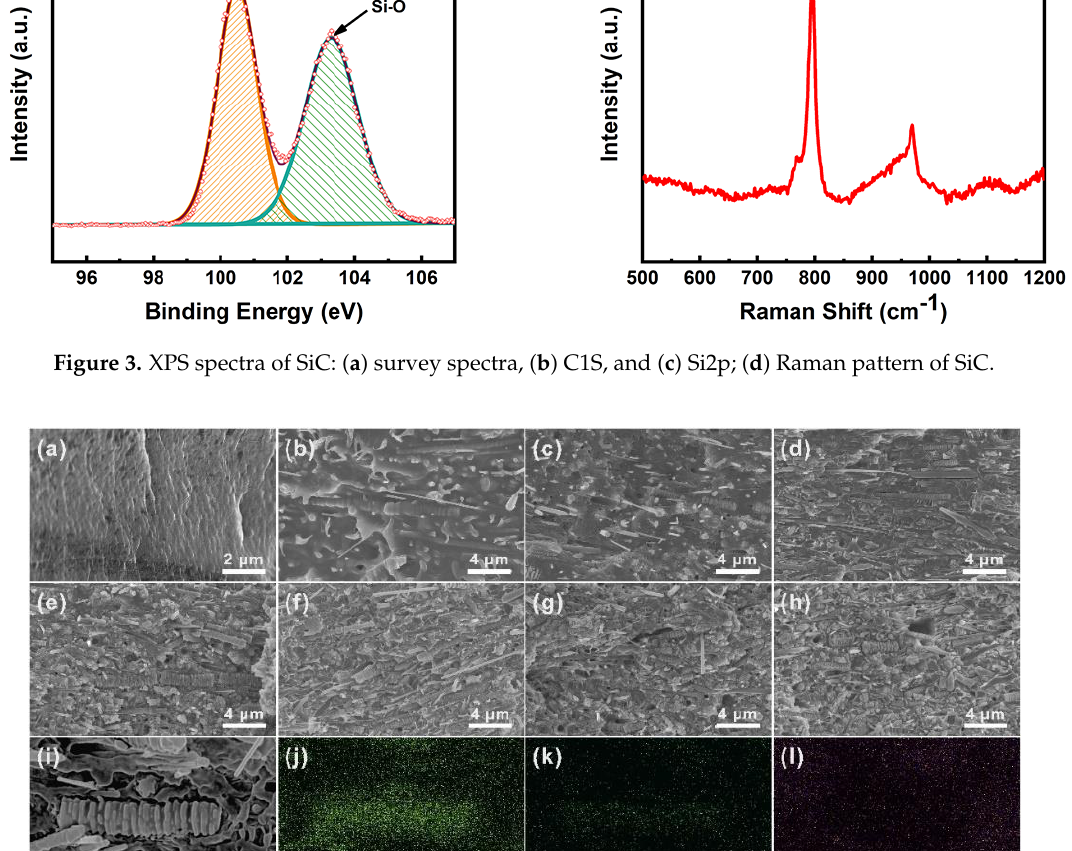
Figure 4. ( a ) SEM image of cross section of pure PVDF. Sectional SEM images of SiC/PVDF with ( b ) 10 wt%, ( c ) 20 wt%, ( d ) 30 wt%, ( e ) 40 wt%, ( f ) 50 wt%, ( g ) 60 wt%, and ( h ) 70 wt% filler content. ( i ) Enlarged SEM image of the 70 wt% SiC/PVDF and corresponding EDS mappings of ( j ) Si, ( k ) O, ( l ) F and C elements.